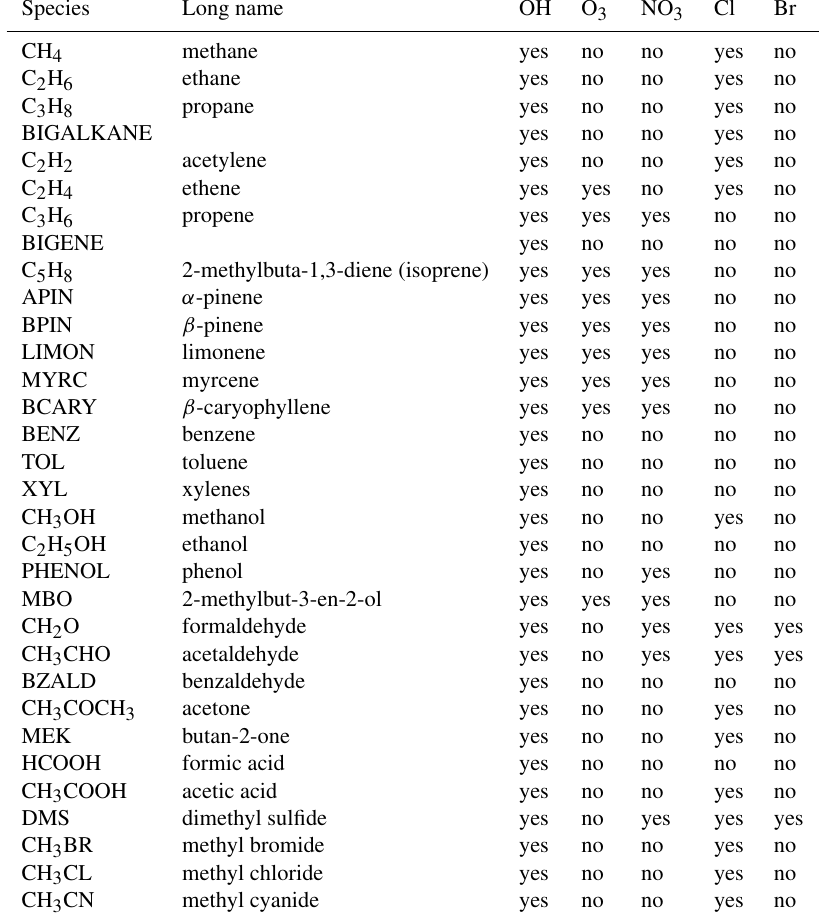
Table 1. Primary volatile organic compounds and their oxidants in the JAM002 mechanism. BIGALKANE is a lumped species for all alkanes C 4 and greater, BIGENE lumps all alkenes C 4 and greater, and o-, m-, and p-xylene are lumped into one xylene species. CH 4 is also oxidized by O ( 1 D ) and F, CH 2 O is also oxidized by O and HO 2 , DMS is also oxidized by BrO, and CH3Br and HCN are also oxidized by O ( 1 D )